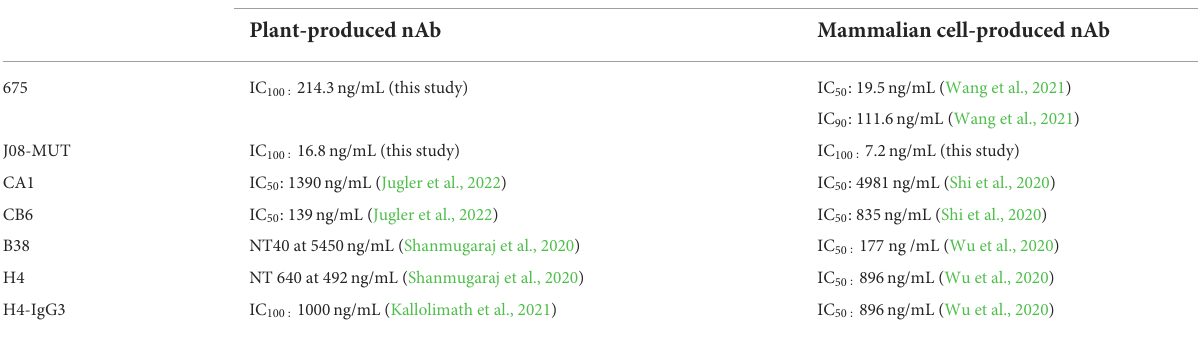
TABLE 1 Comparison of neutralization potencies of the same nAbs obtained in plants and mammalian cells.